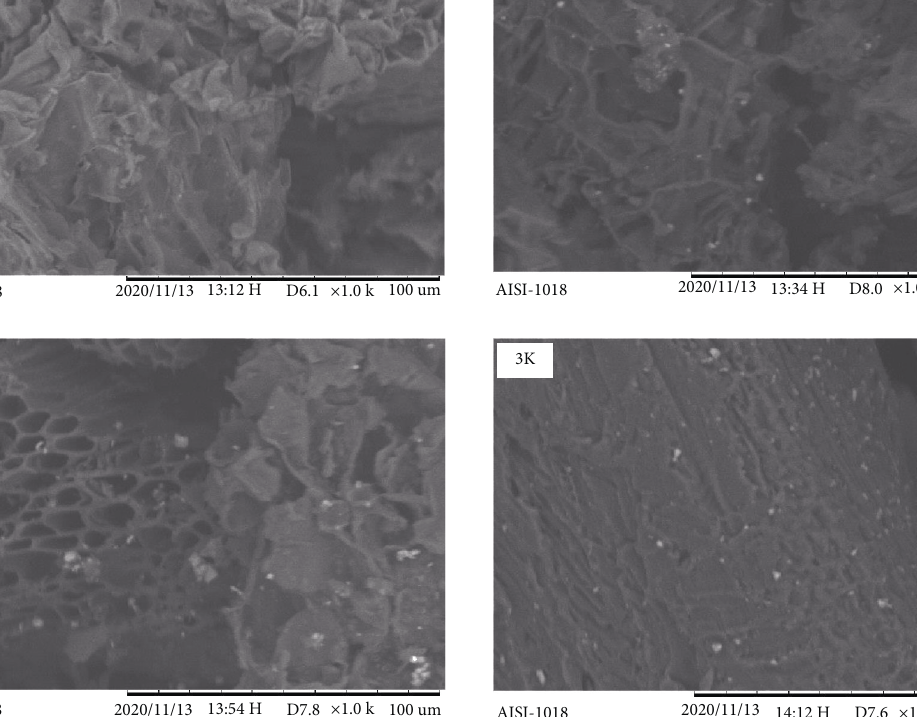
Figure 6: SEM images of alkaline and acidic heterogeneous catalysts used in the transesterification of safflower oil with methanol to obtain